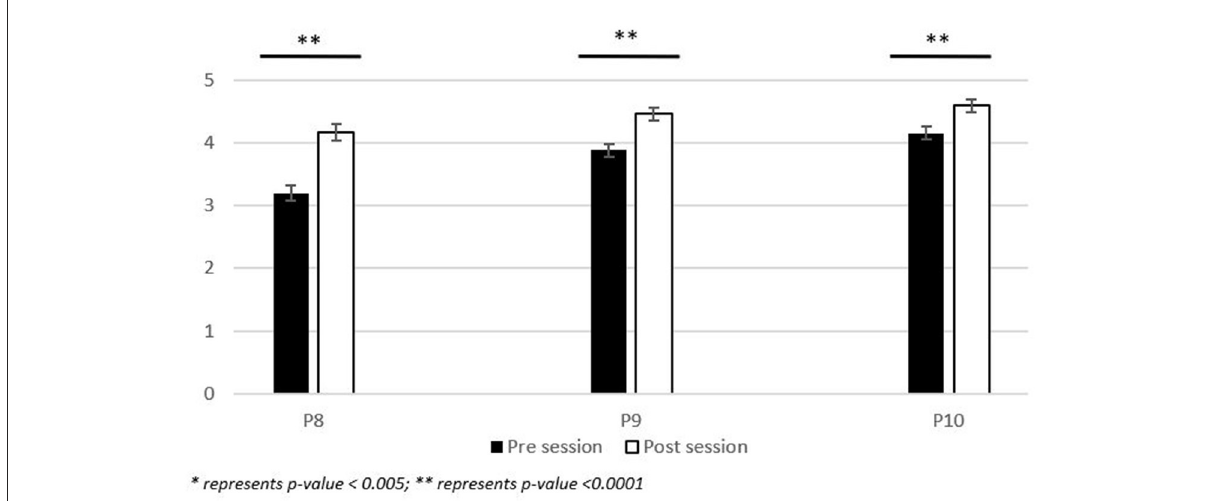
FIGURE3 Participant reported change in the level of confidence related to LGBTQIA + areas of concern. Range of significance of results of the pre-/post- activity survey responses ( n = 111) to the following prompts: (P8) How confident are you in your knowledge of primary care of Lesbian, Gay Bisexual, and Transgender (LGBTQIA + ) patients? (P9) How confident are you in your ability to identify implicit bias toward LGBTQIA + individuals demonstrated by a colleague/classmate? (P10) How confident are you in your ability to create an environment which fosters others to comfortably disclose their gender identity to you? Participants responded on a 5-point Likert scale with 5, Extremely Confident; 4, Somewhat Confident; 3, Neutral; 2, Minimally Confident; 1, Not Confident at all. Data is represented as the average response from the Likert scale + /– the standard error of the